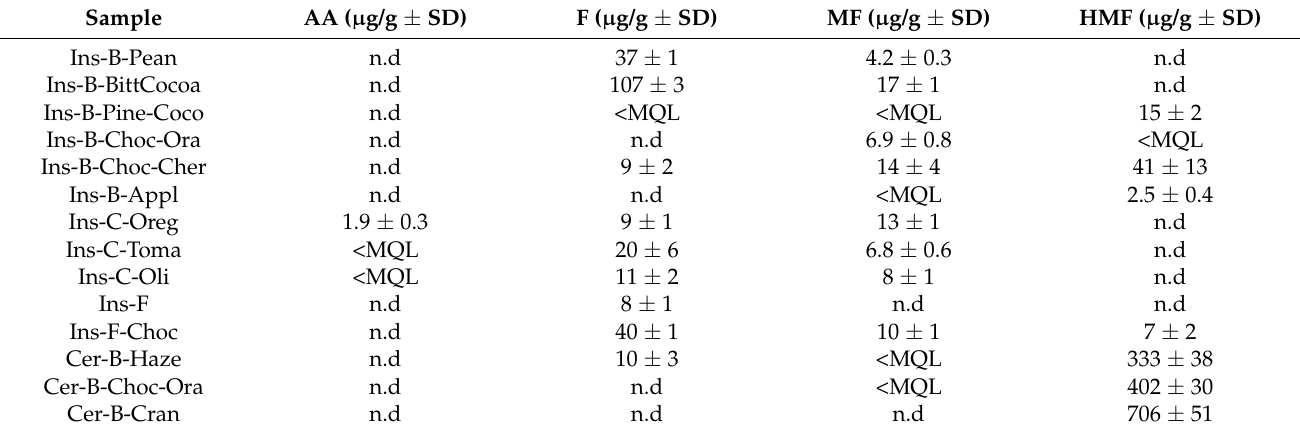
Table 5. Content of acrylamide (AA), furfural (F), 5-methylfurfural (MF) and hydroxy-methyl-furfural (HMF) in the different insect-based food samples analyzed with the proposed